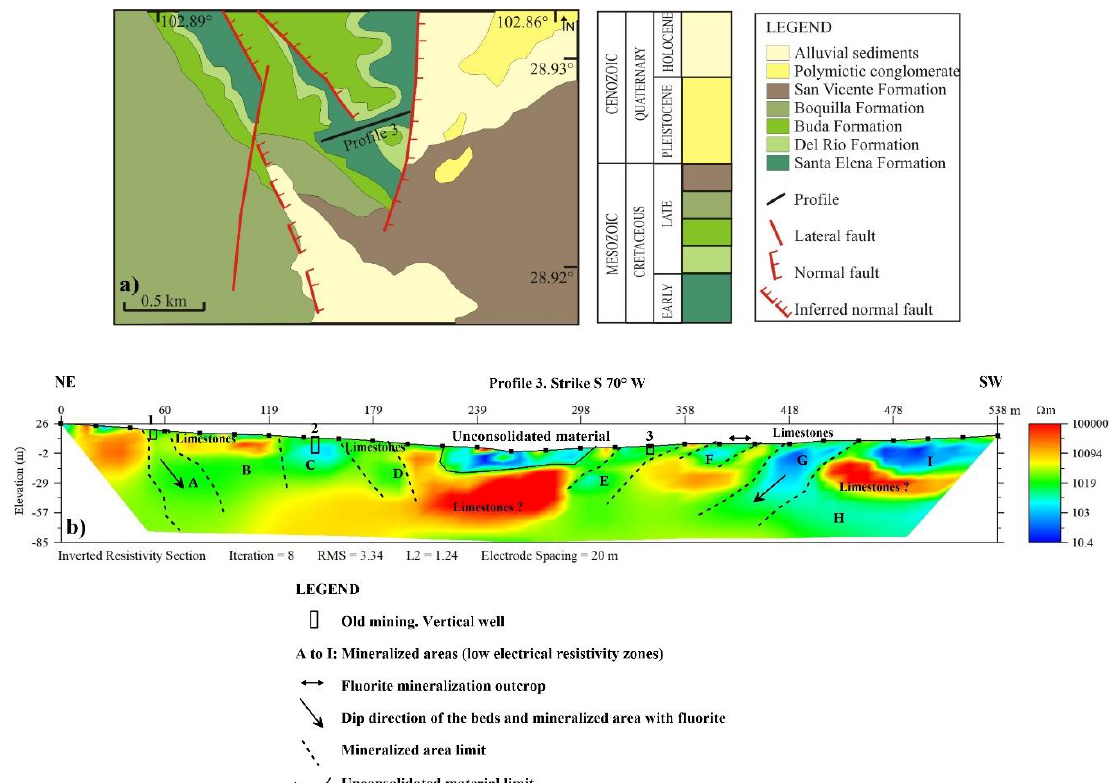
Figure 6. ( a ) Geological map of the Otomí mine. Modified from Ramírez-Gutiérrez and Chávez-Rangel [19]. ( b ) Inverted resistivity section. ERT in MVT fluorite deposit. The stratigraphic column is not to scale.